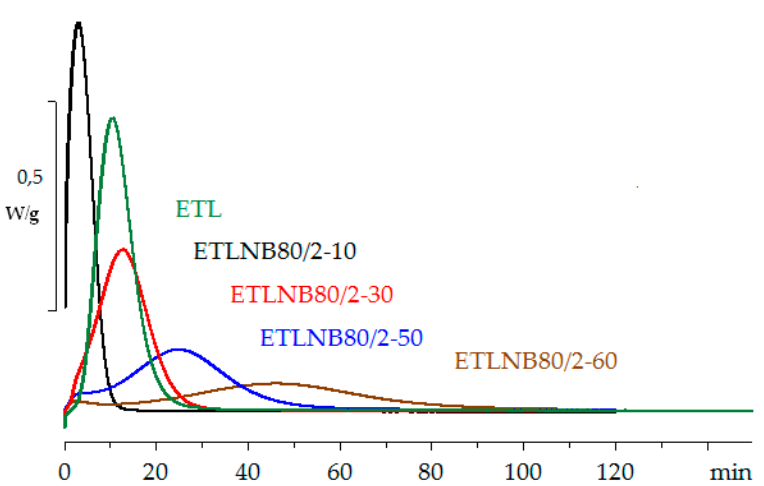
Figure 7. Isothermal DSC cure curves for ETL (green), ETLBN80/2-10 (black), ETLBN80/2-30 (red), ETLBN80/2-50 (blue), and ETLBN80/2-60 (brown) at 70 °C. Exothermic direction is upward. The peak height decreases with increasing BN content, except for ETLBN80/2-10.